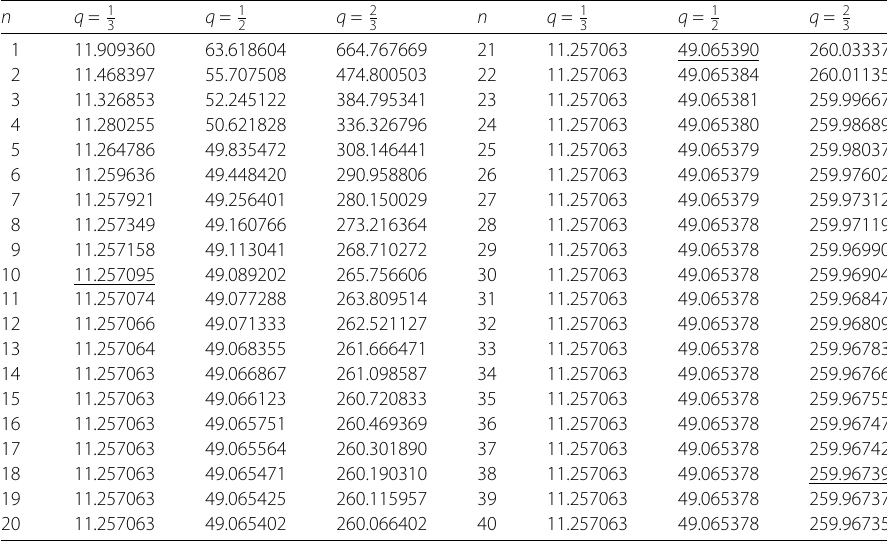
Table 3 Some numerical results for calculation of Γ q ( x ) with x = 8.4, q = 1 Algorithm